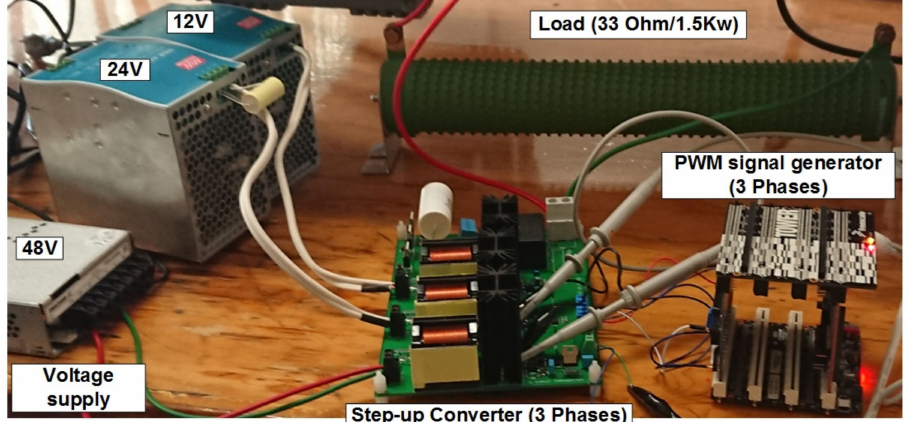
Figure 13. Experimental prototype with three input voltage sources, 33 Ω output load and the PWM signal